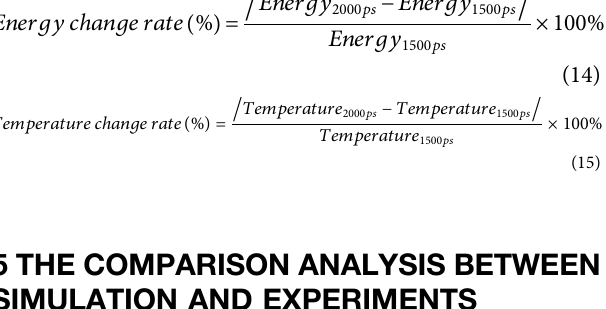
Figure 9 . The consecutive snapshots (1,500 – 2000 ps) of fi ve surfactants-SiO 2 nanoparticles adsorption onto the modelled calcite surface were shown in Figure 10 . Figures 9 , 10 showed that both the surfactants and surfactants-SiO 2 nanoparticles adsorption was stable after 1,500 ps, in other words, the position of the surfactant molecules and SiO 2 nanoparticles remained stable after 1,500 ps Supplementary Figures S8, S10 showed the energy balance of surfactants-calcite system and surfactants-SiO 2 nanoparticles calcite system. As was shown in Supplementary Figures S8, S10 , the red line represents kinetic energy, and the kinetic energy remained stable, and non-bond energy, potential energy and total energy decreased with simulation time proceeded. The non-bond energy, potential energy, and total energy decreased signi fi cantly within 100 ps, and then three energies would become stable. Supplementary Figures S9, S11 showed that the temperature stabilized at 298K, and the temperature fl uctuation range was within 10 K. Energy change rate from 1,500 ps to 2000ps could be calculated by Eq. 14 , and temperature change rate from 1,500 ps to 2000 ps could be calculated by Eq. 15 . Table 1 showed the energy change rate and temperature change rate (%) (1,500 ps – 2000 ps) of surfactants (with and without SiO 2 nanoparticles) system. The temperature change rate for the fi ve surfactants (with and without SiO 2 nanoparticles) was low. The potential energy, kinetic energy, non-bond energy and total energy change rate were also low.